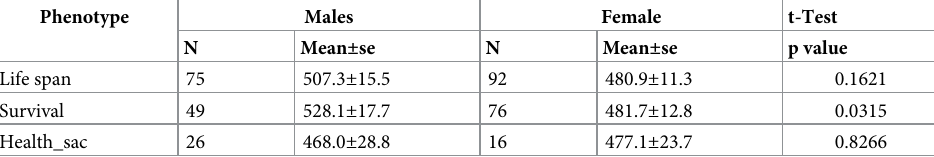
Table 1. Effect of sex on life span of F2 G59S-hDCTN1 mice.